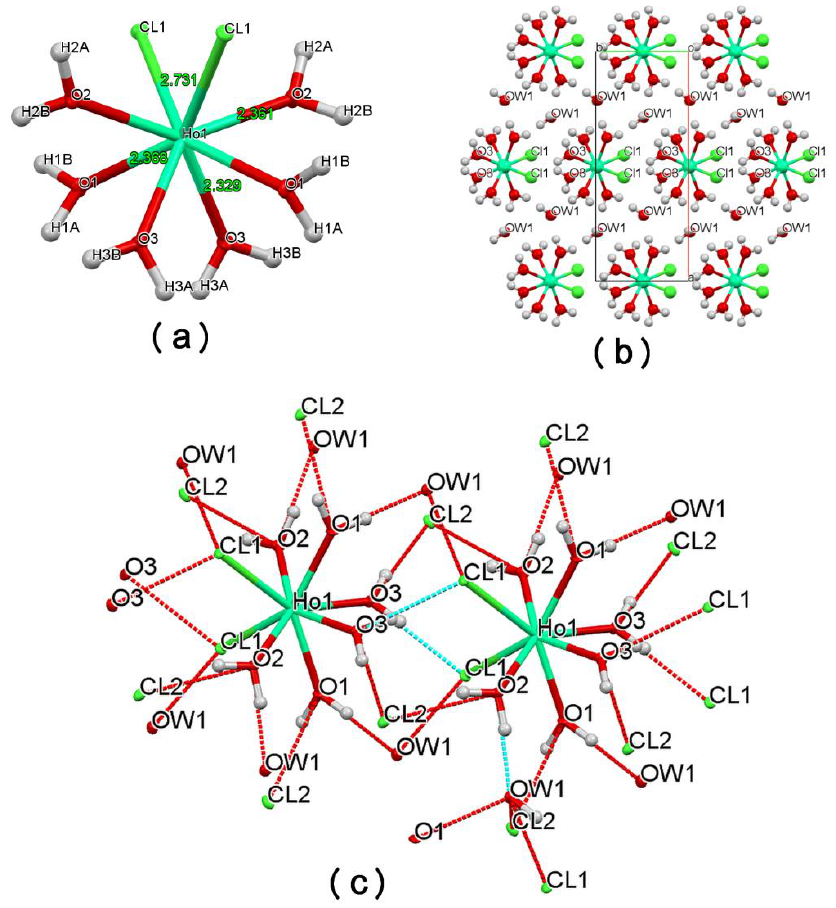
Figure 5. ( a ) Structure of the [HoCl 2 (H 2 O) 6 ] + cation in 1 . ( b ) Chains of holmium cations. ( c ) A fragment of the inorganic layer showing hydrogen bonds of the Ho (III) ligand environment with crystallization water molecules OW1 and chlorine anions Cl2 located between the organic and inorganic cation layers.